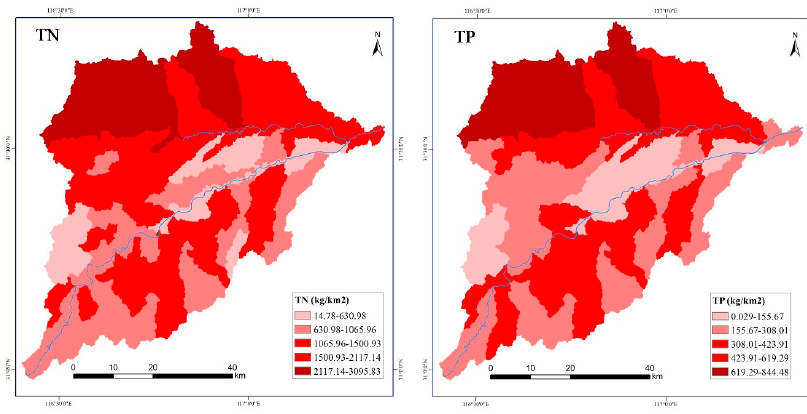
Figure 4. The spatial distribution characteristics of TN and TP. Table 5. Annual output intensity of TN and TP in di ff erent FLTs.